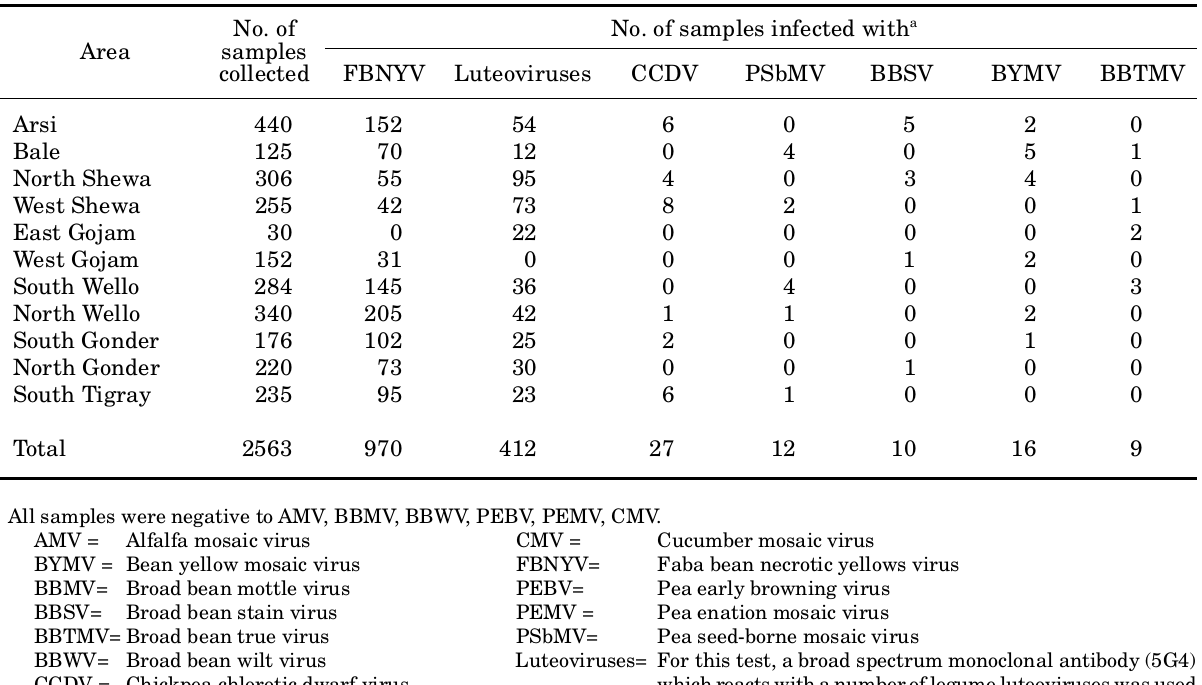
Table 2. Results of serological tests of symptomatic samples collected from 176 faba bean fields in the major produc- tion areas of Ethiopia during 1996. No. of No. of samples infected with a Area samples collected FBNYV Luteoviruses